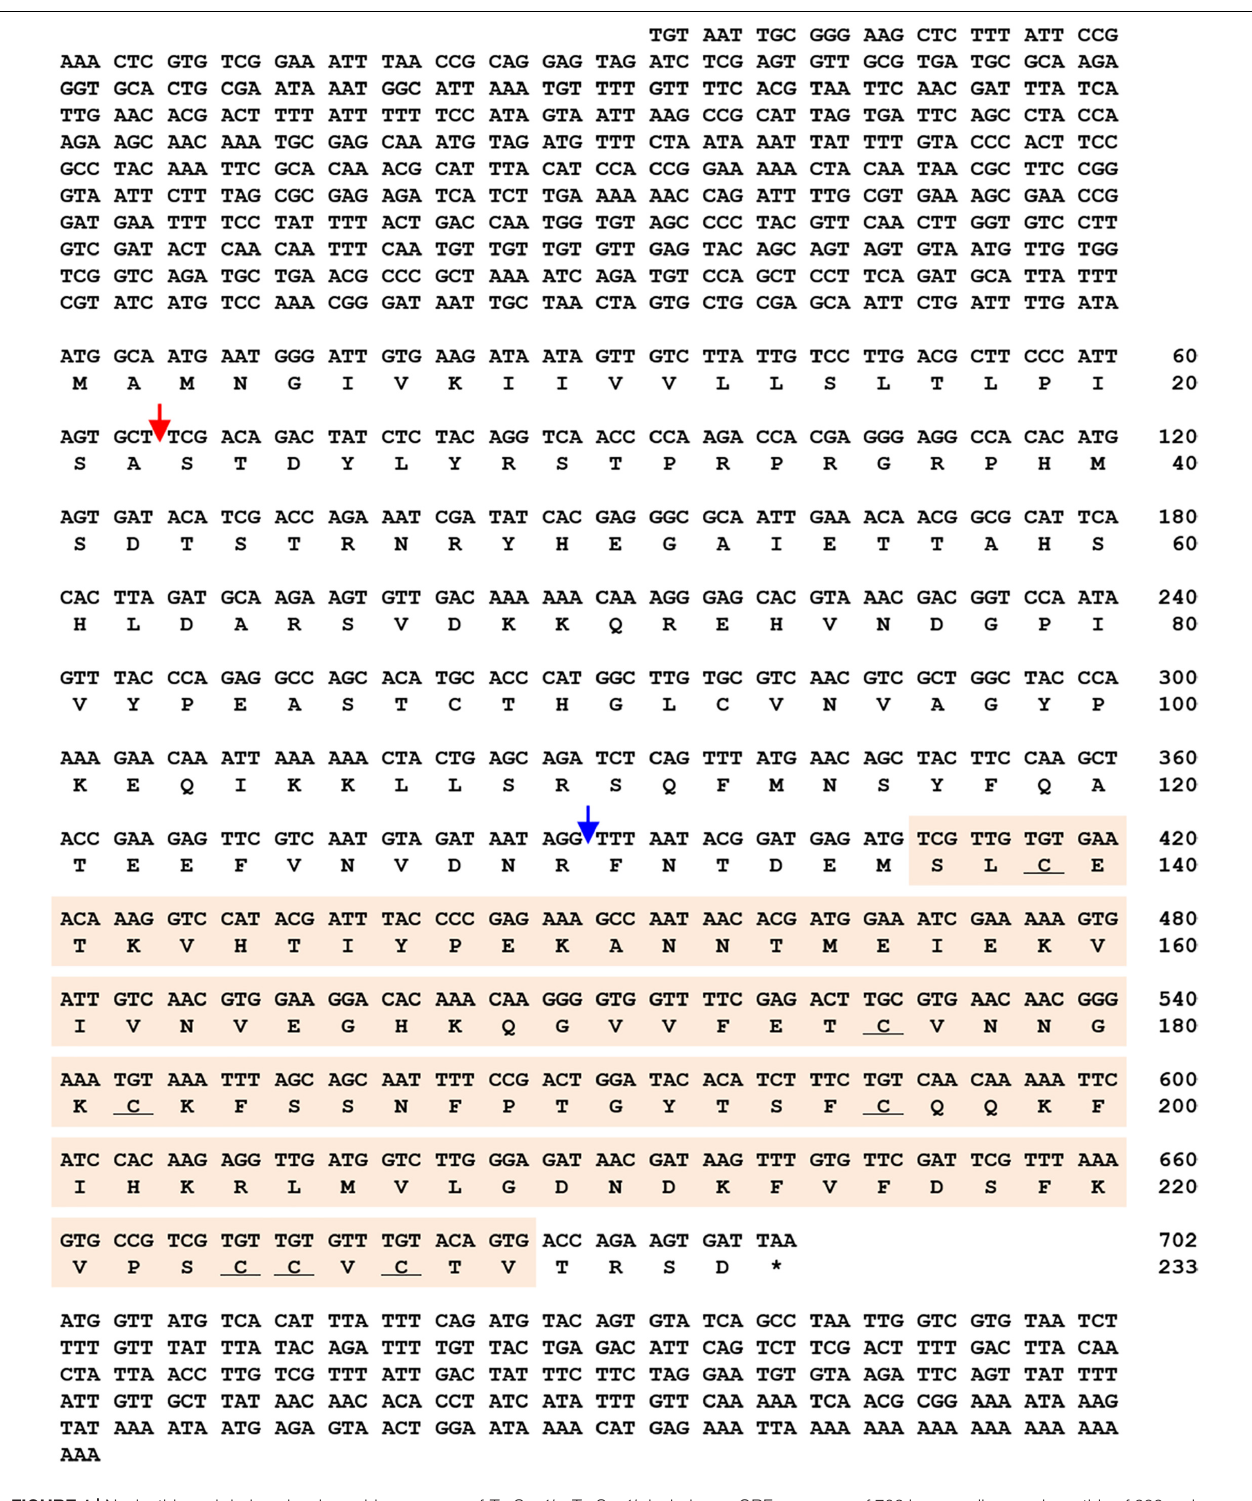
Frontiers in Physiology |